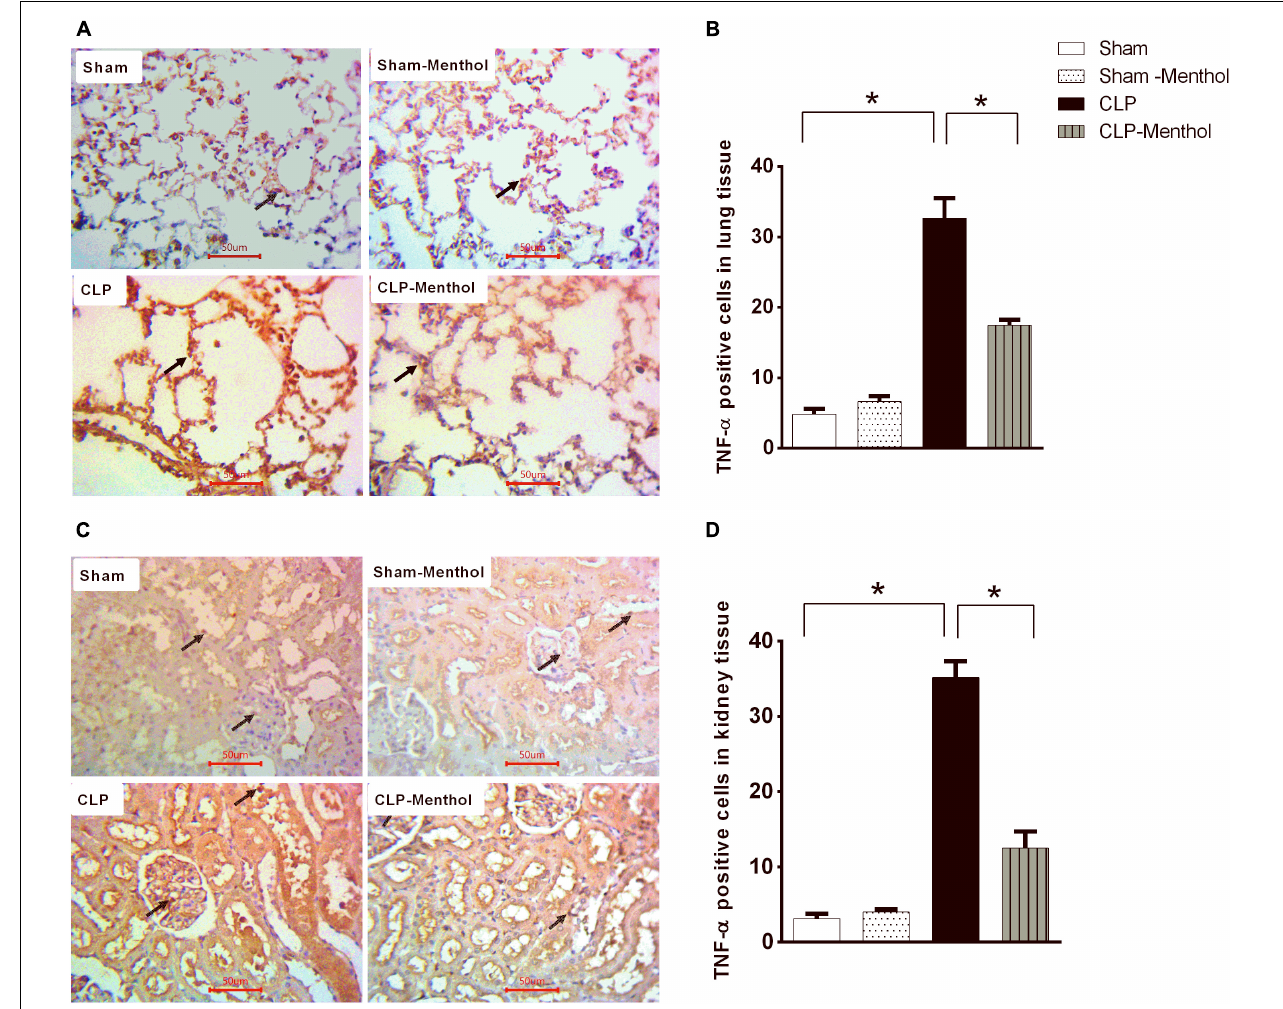
FIGURE 6 | Effect of Menthol on TNF- α expression in the lung and kidney tissue of septic rats. Immunohistochemical staining of TNF- α in paraffin-embedded lung (A) and kidney (C) sections was carried out as described under the “Materials and Methods” section. Rabbit monoclonal anti-TNF- α (cat. # EPR21753-109, Abcam, Cambridge, United Kingdom) was used to probe tissue TNF- α . Ten random fields per slide from each group ( n = 6) were selected and imaged (400X). The mean surface area fraction of TNF- α immuno-positive cells was measured using ImageJ software. Representative photomicrographs (A) showing TNF- α immunoreactivity in lung tissues. Bar charts (B) show semi-quantitative analysis of data in A from sections of the sham, sham-Menthol, CLP, and CLP-Menthol groups. TNF- α immunoreactivity in kidney sections (C) from all groups are semi-quantitatively analyzed in (D) . Data represent the mean ± SEM of 6 independent observations. Data were analyzed by one-way ANOVA followed by the Tukey-Kramer post-test for multiple comparisons. *Significantly different at p < 0.05 compared to the CLP